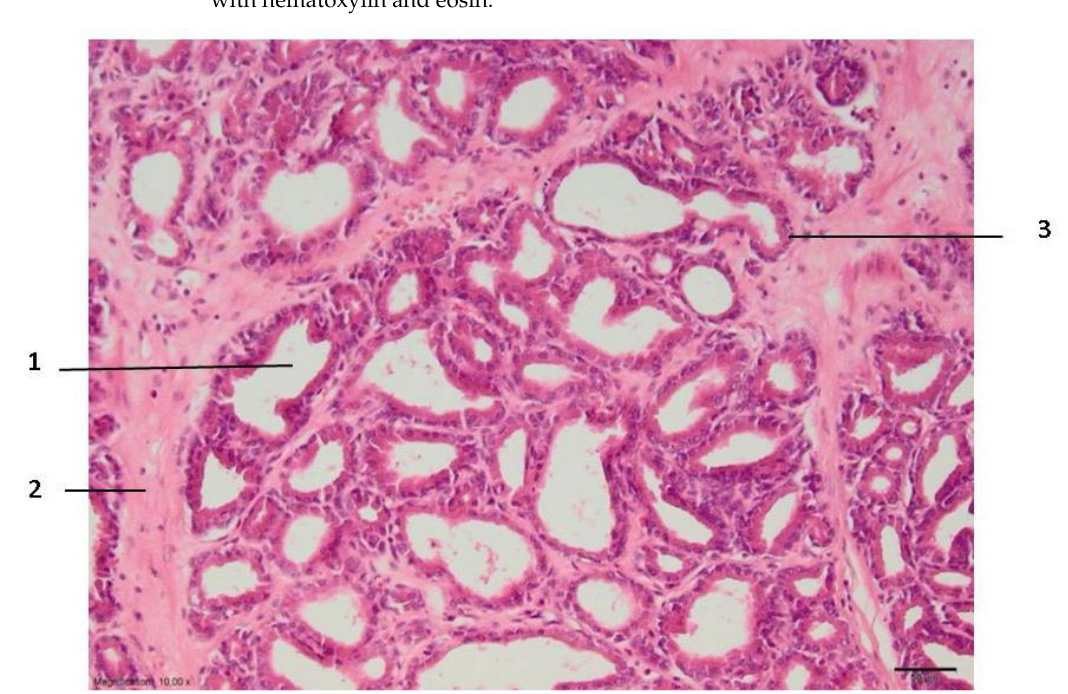
Figure 5. Intact zone of the prostate. Normal tissue structure: 1—glandular epithelium; 2—stroma; 3—prostatealveolus. Microtome-cutsectionsofprostatesampleswerestainedwithhematoxylinand eosin. The average of P-III in session C.09 was the highest and statistically significantly lower in session C.01. Moreover, the average of P-II was the highest in session C.09 and the lowest in session C.01. There was no statistically significant difference between P-II in sessions C.01 and NC. Comparing the length of P-II, a statistically significant difference between sessions C.09 and C.01 was observed, as well as between sessions C.09 and NC. Whereas C.01 and NC did not show a statistically significant difference. It was